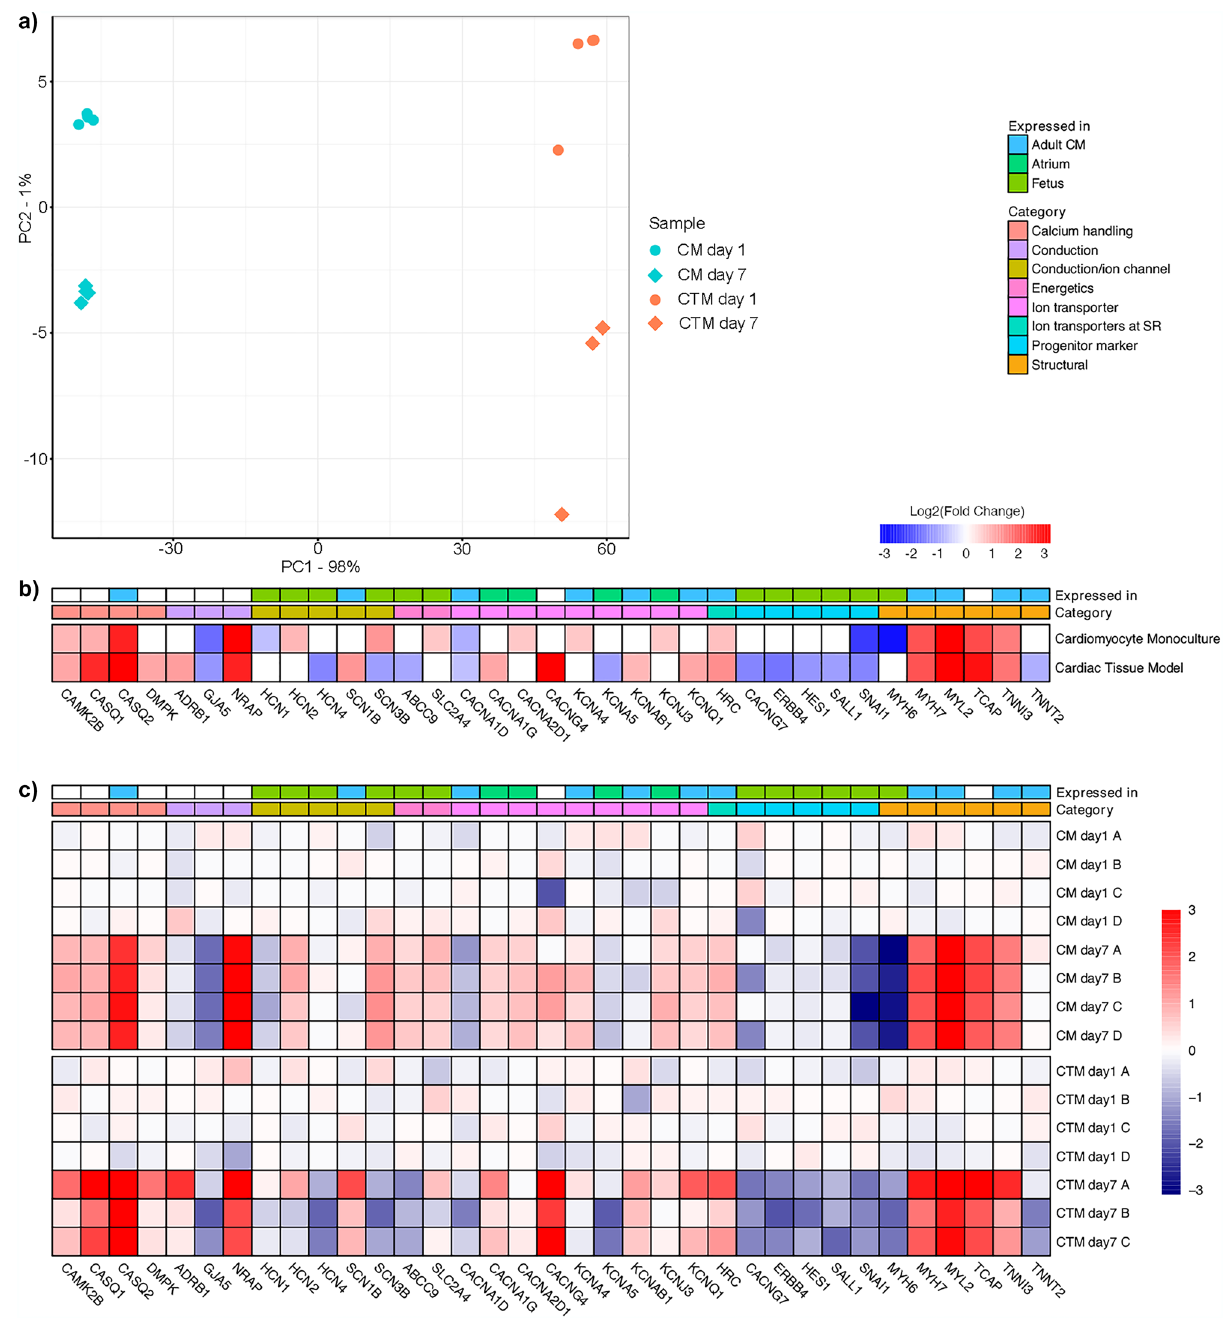
Figure 4. Cardiomyocyte gene expression profile reached a more mature state in cardiac tissue model than in monocultured cardiomyocytes. ( a ) PCA plot of cardiomyocyte monoculture (CM day 1 & CM day 7) and cardiac tissue model (CTM day 1 & CTM day 7) samples using top 500 most variable genes and variance stabilizing transformation (DESeq2). Numbers attached to the principal components correspond to the percentage of variance that is attributed to it. ( b ) Heatmap of the log2-transformed fold changes (day 1 to day 7) of the cardiomyocyte monoculture and cardiac tissue model samples. Pre-selected genes of interest are annotated according to category and typical site of expression. Values for genes with a statistically insignificant fold change (padj > 0.05) are not reported. ( c ) Heatmap of expression changes per gene for each sample. The DESeq2-normalized count of each gene was additionally normalized against the mean of the day 1 expression of each gene. Day 1 normalization was done separately for CM and CTM, followed by a log2 transformation. Genes and their annotations correspond to those of ( b ). Number of replicates from two repeats n = 4 for CTM day 1, CM day 1 and CM day 7; n = 3 for CTM day 7. The heatmaps were created in R 3.6.0 using